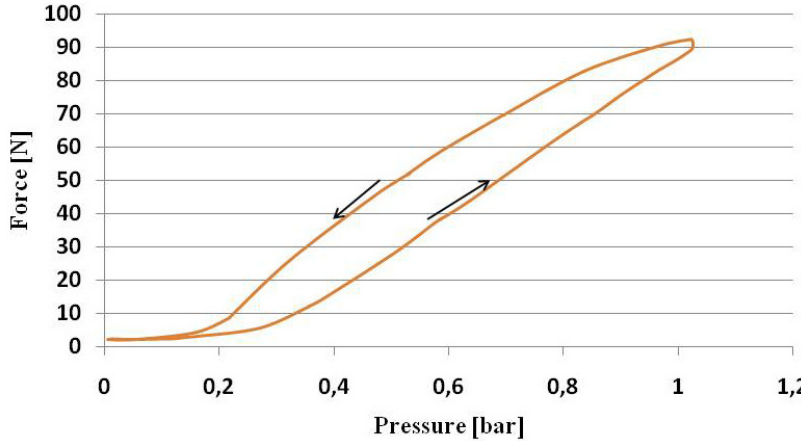
Figure 11. Force-pressure tests on a textile